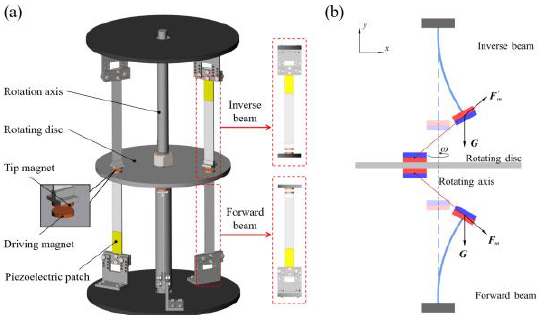
Figure 1. ( a ) Schematic diagram of rotational magnetic couple piezoelectric energy harvester; ( b ) schematic diagram of the magnetic plucking process of the harvester.